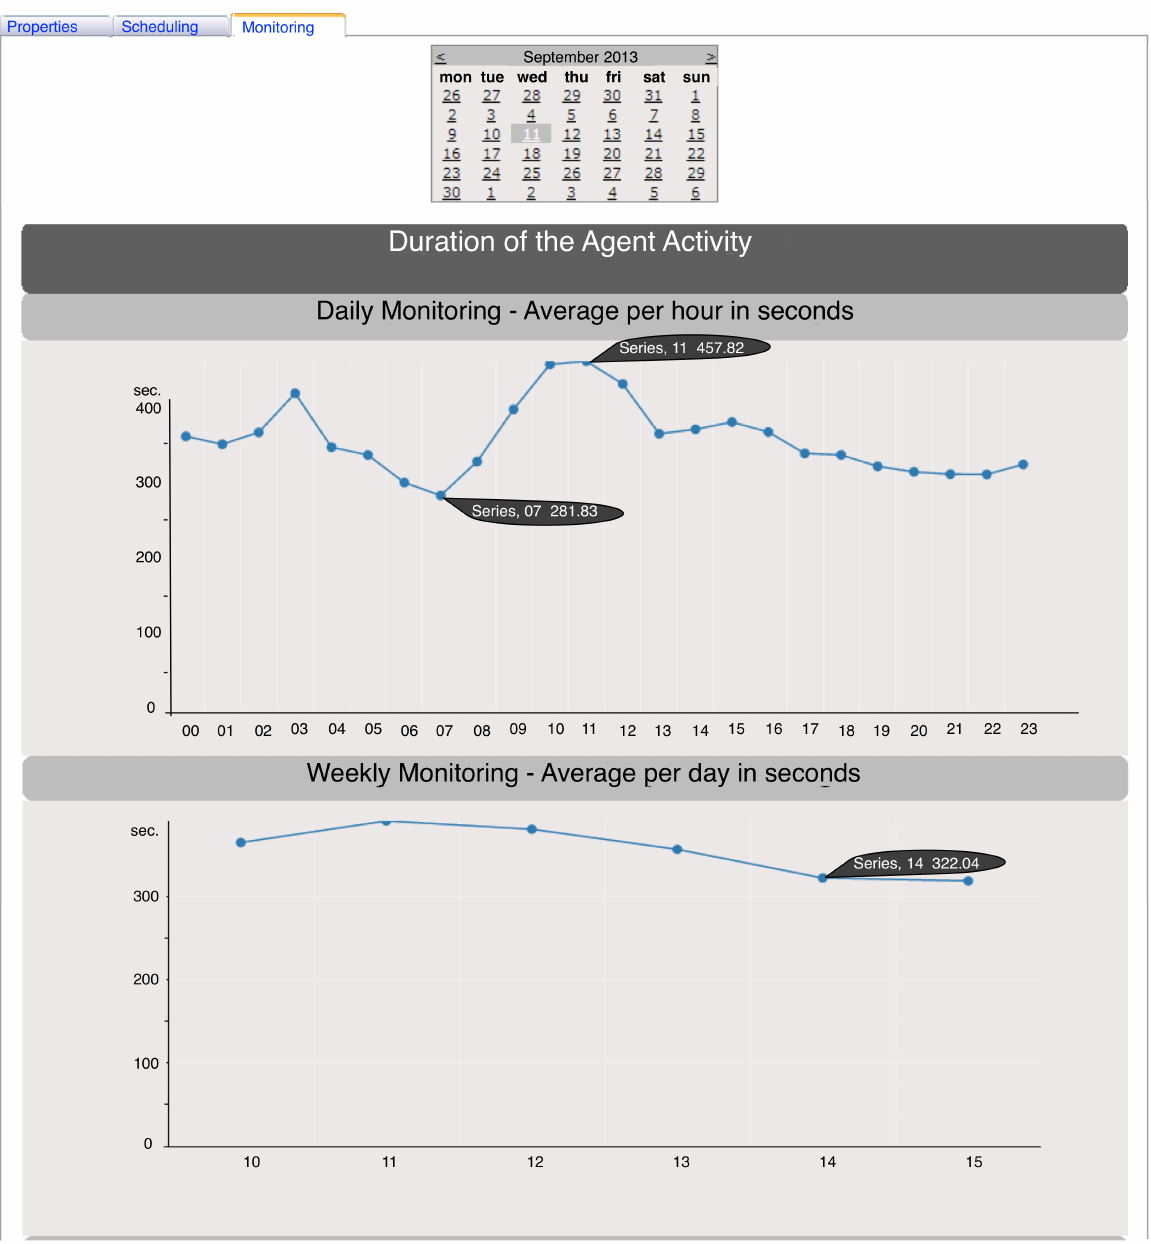
Figure 6. Daily and weekly analysis of the duration of an agent activity on 11 September